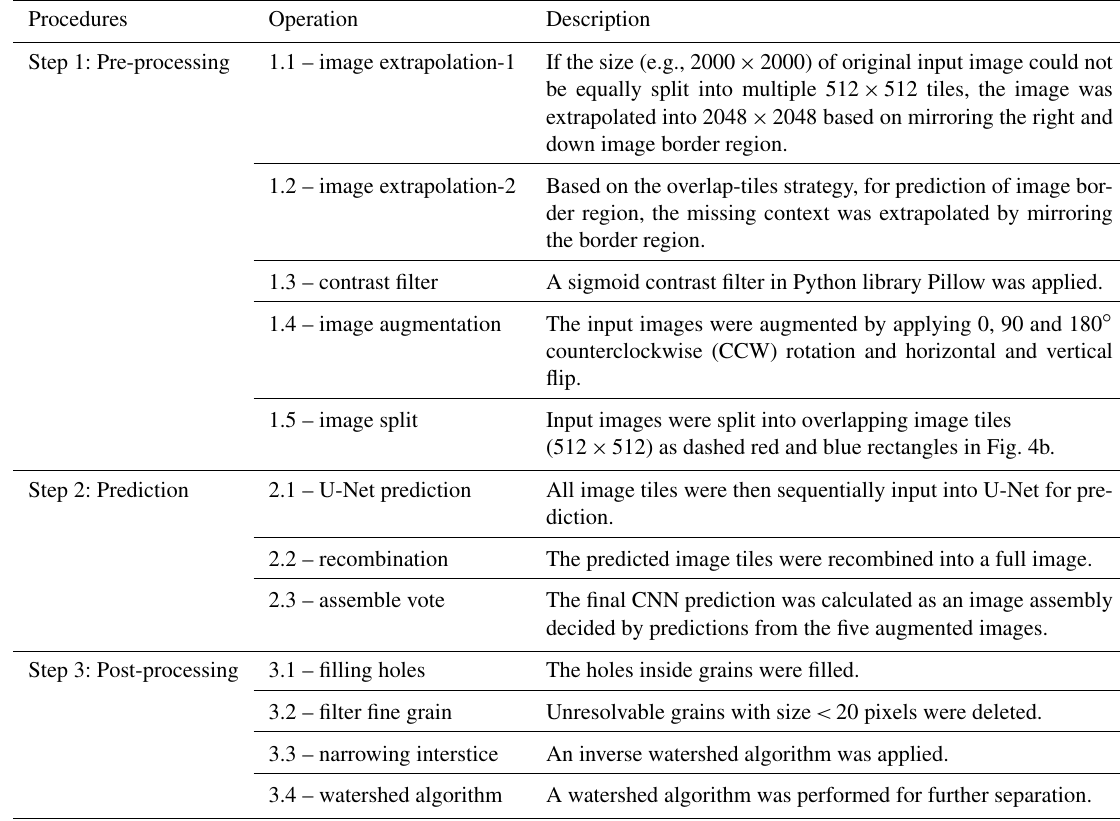
Table 2. Description of each image processing step of GrainID.